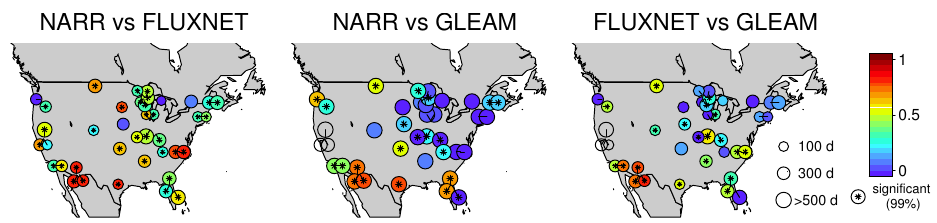
Figure 5. Correlation of daily JJA before-noon EF values between different data sets. The size of the dots indicates the number of days included in the computation according to the legend shown on the bottom right, and significant correlations at a 99% level are indicated by a black asterisk. Empty dots for GLEAM indicate sites with unreliable NEXRAD (and thus GLEAM)